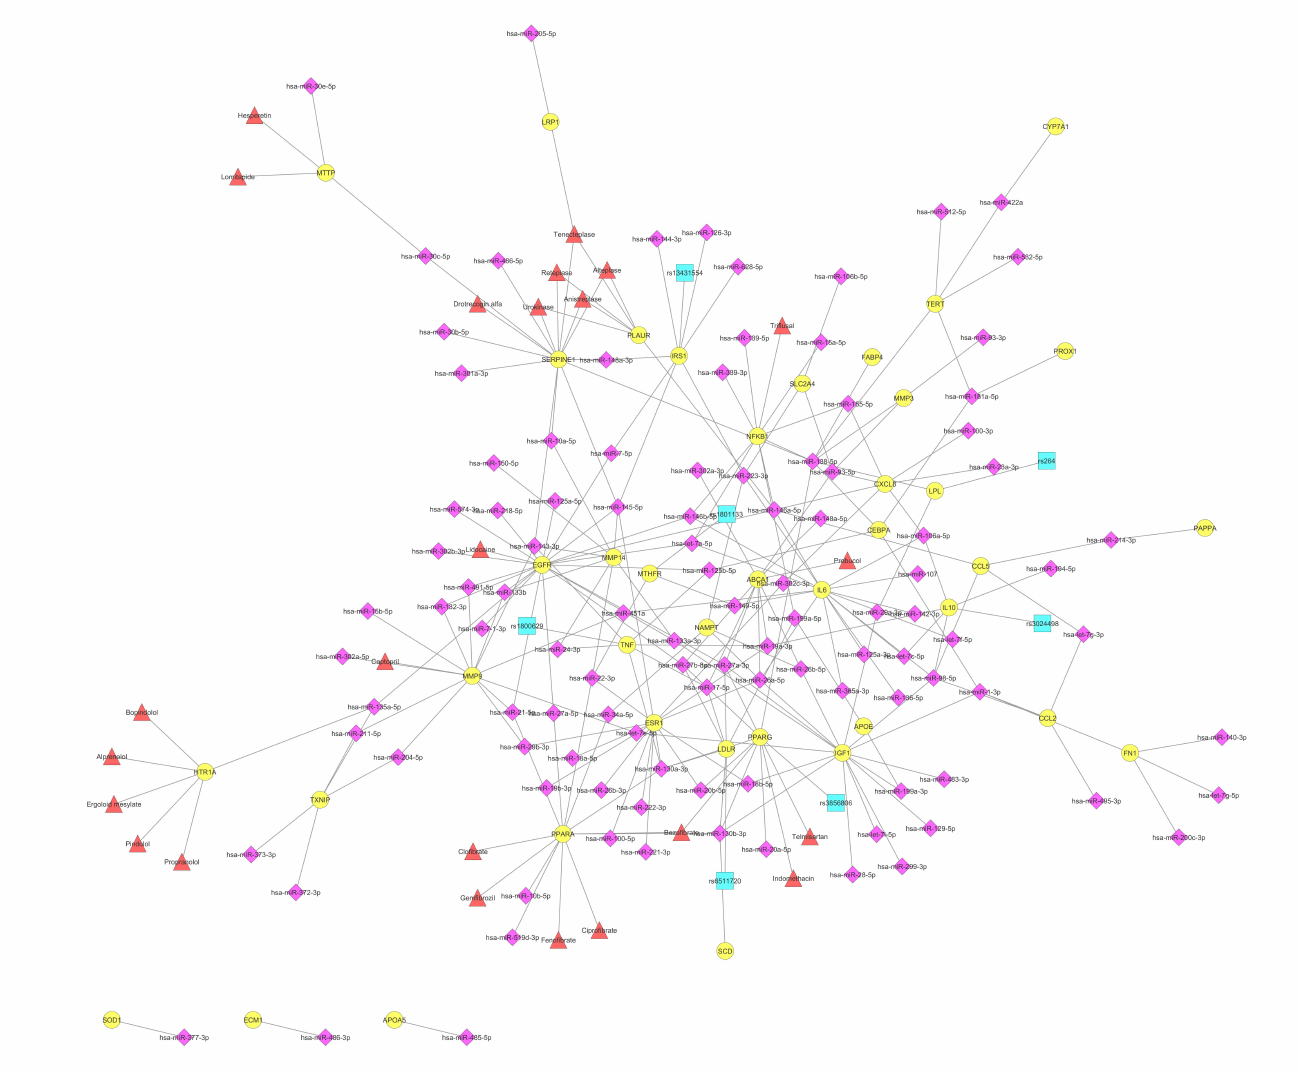
Figure 5. Network of the VTGs enriched within the DOSE term lipid metabolism disorder. The network displays 40 lipid metabolism disorder-associated VTGs (circles in yellow), as well as 109 miRNAs (diamonds in purple), seven SNPs (squares in turquoise) and 24 drugs (triangles in red) that are associated with CVDs, and target and/or affect them. The network was created using Cytoscape